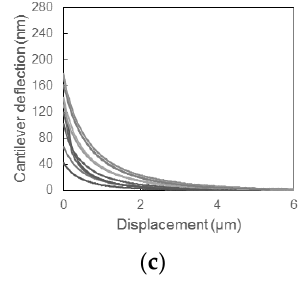
Figure 9. Cantilever deflection-displacement curves for contact-electrified particles treated with different amounts of external additives: ( a ) 0 wt %; ( b ) 0.3 wt %; ( c ) 1.3 wt %.